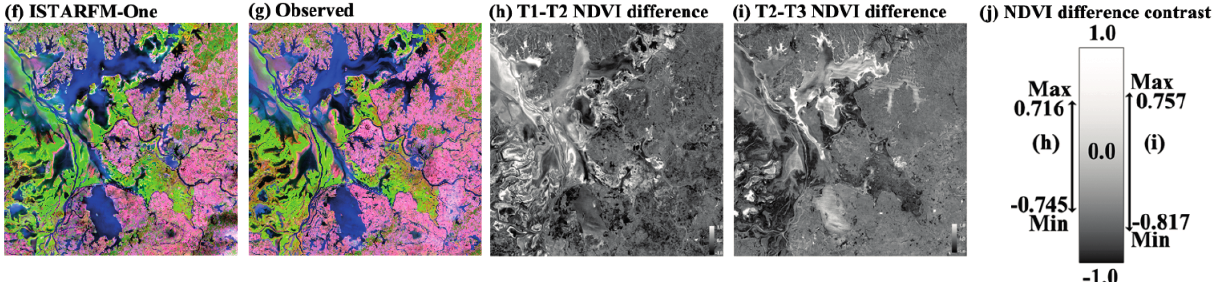
Figure 6. Predicted Landsat-like images and the observed Landsat TM image for the Poyang Lake site on 29 November 2004. Similarly, ( a–d ) Blended images under the two L-M pairs prediction mode; ( e , f ) Blended images under the one L-M pair prediction mode. ( g ) Observed ETM+ image; The NDVI difference image ( h ) between the prior and predicted dates, and ( i ) between the predicted (T2) and posterior (T3) dates, respectively; ( j ) The NDVI difference contrast of (h) and (i).